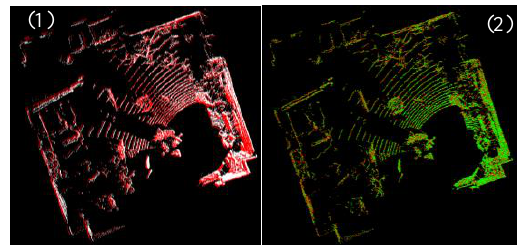
Figure 16. Situation of two sequential scans before (1) and after (2) registration.